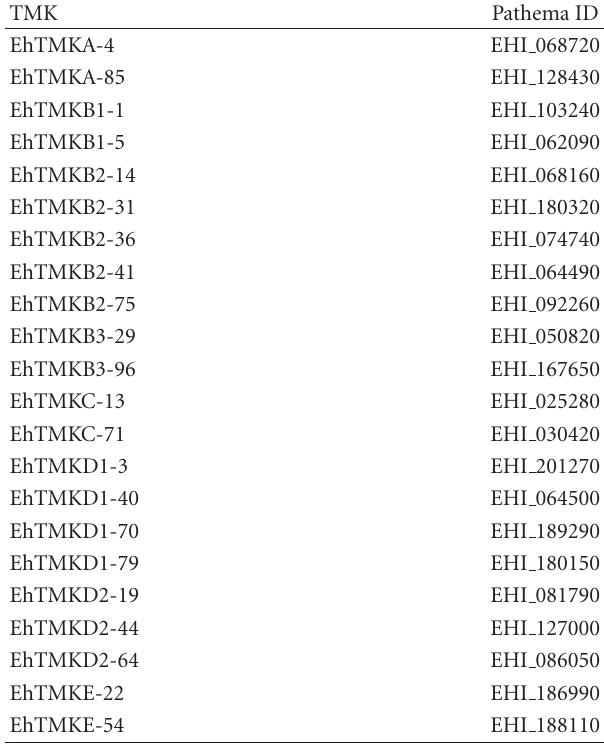
Table 1: Members of the Entamoeba histolytica transmembrane kinase family found in phagosome preparations at various time points [80,